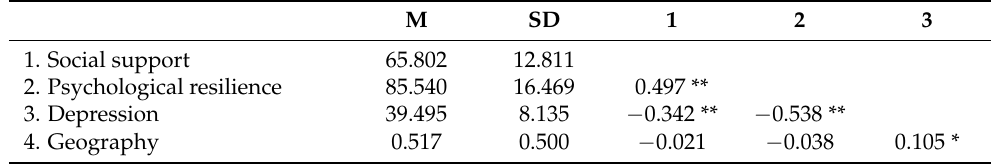
Table 2. Mean, standard deviations, and correlations among variables (N =